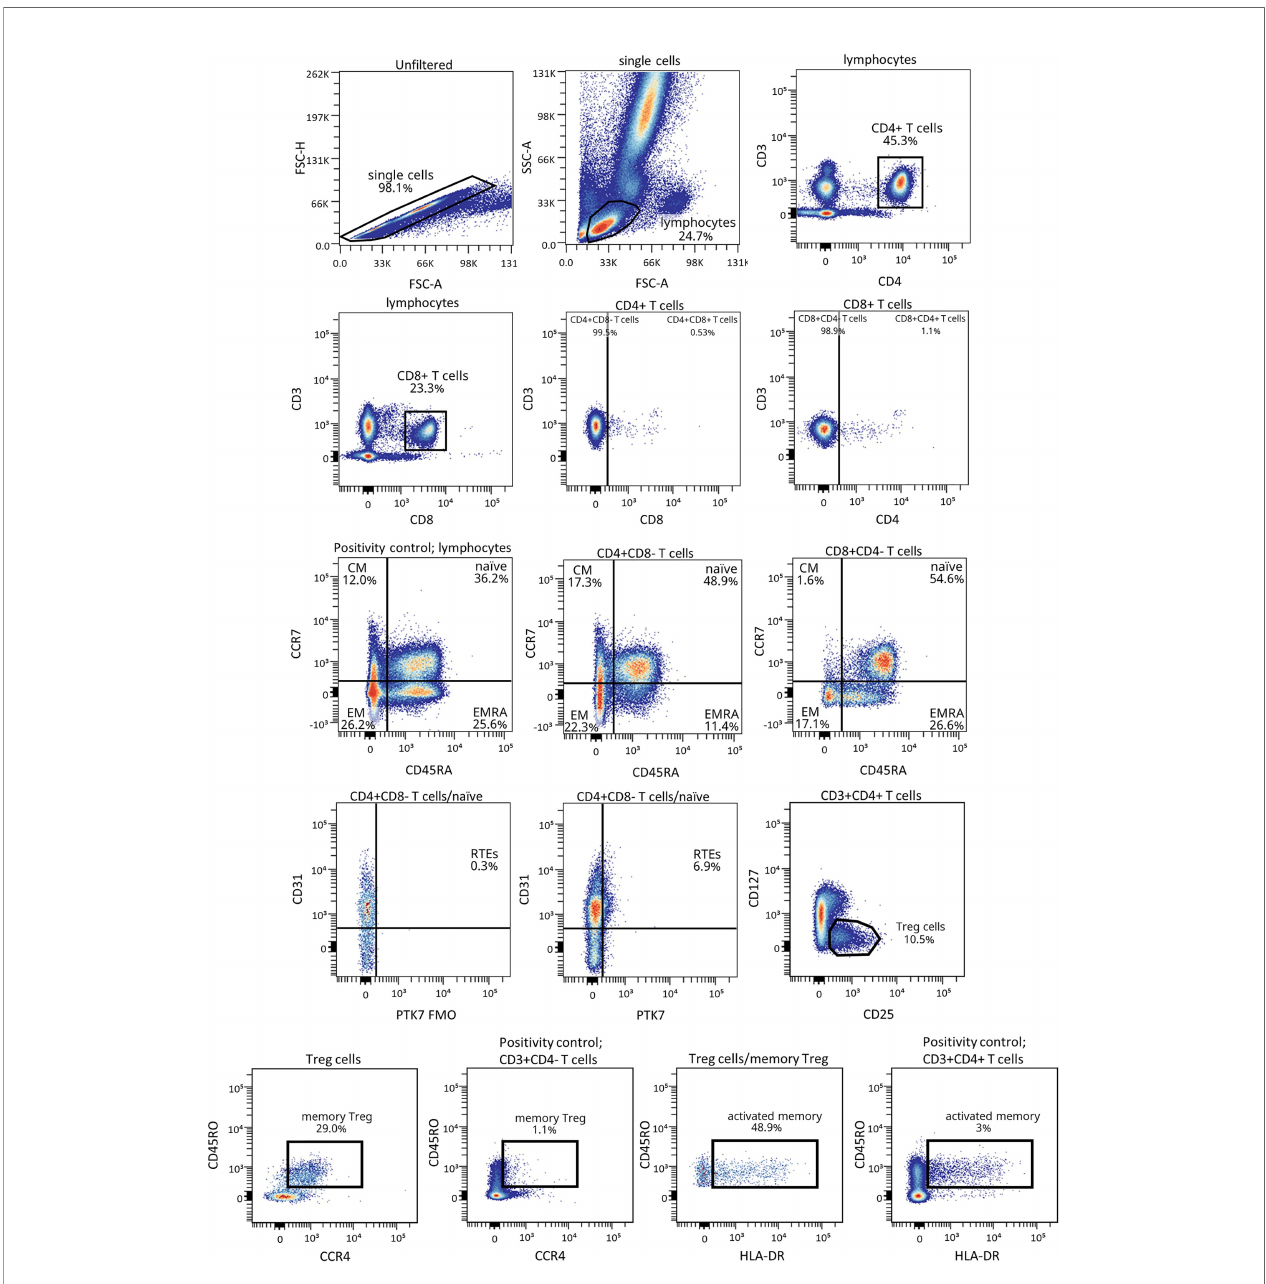
FIGURE 1 | Representative gating strategy for the T lymphocyte maturation stages and T REG panels. Gating strategy used to analyze the percentages of the different CD4 + and CD8 + T cell subsets based on the expression of the markers CD3, CD4, CD8, CD45RA and CCR7, and of CD127, CD25, CD45RO, CCR4 and HLA-DR for T REG subsets within CD4 + T cells. CD31 and PTK7 were used to characterize RTEs. Positivity controls for CCR7 vs CD45RA using lymphocytes, for CD45RO vs CCR4 using CD4 - T cells and for CD45RO vs HLA-DR using CD4 + T cells as internal reference populations. FMO control for PTK7 was